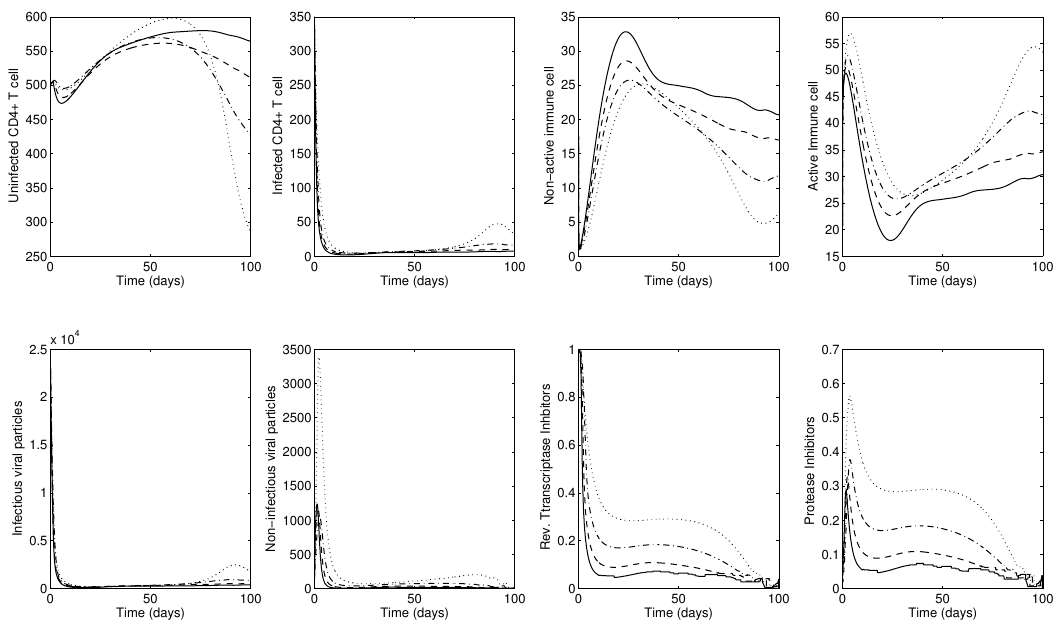
Figure 8. Advanced-stage dynamics of infection with two controls under four different values of γ ( β = 0.000025 and A = B = 12,500 are used): γ = 0.016 (solid), γ = 0.012 (dashed), γ = 0.008 (dash-dot) and γ = 0.004 (dotted). The bottom two right panels show optimal controls for reverse transcriptase inhibitor ( u 1 ) and protease inhibitor ( u 2 ) for 100 days. Under larger values of γ (solid), both controls are decreasing and the average number of active immune cells M ∗ is